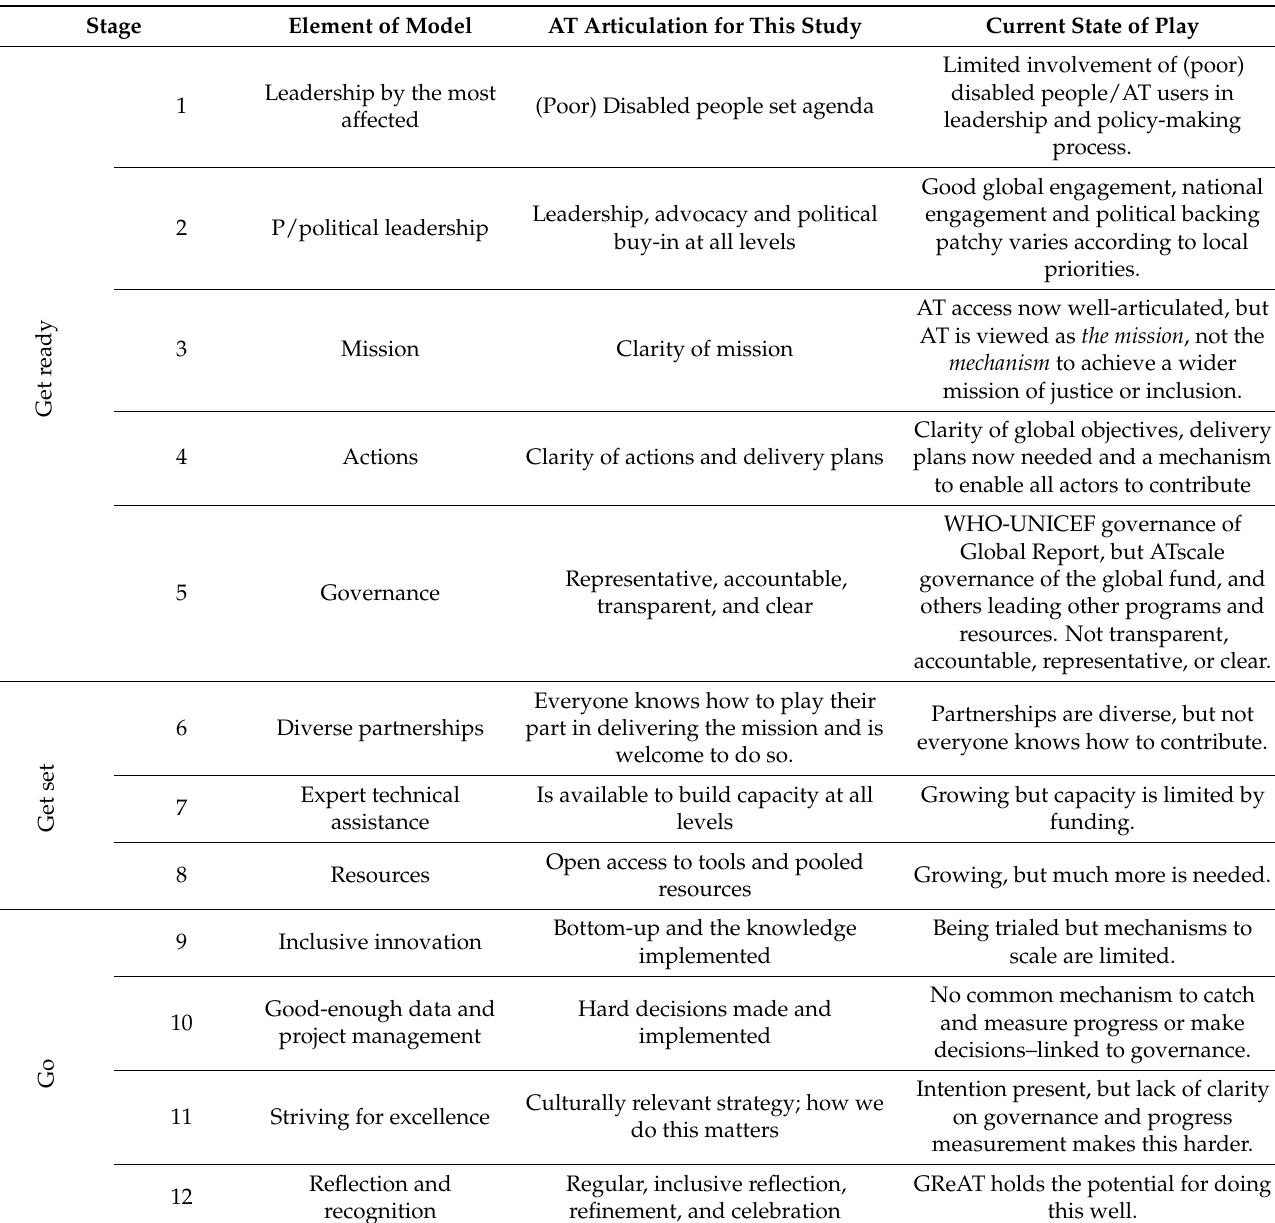
Table 1. London 2012 12 Step Model applied to